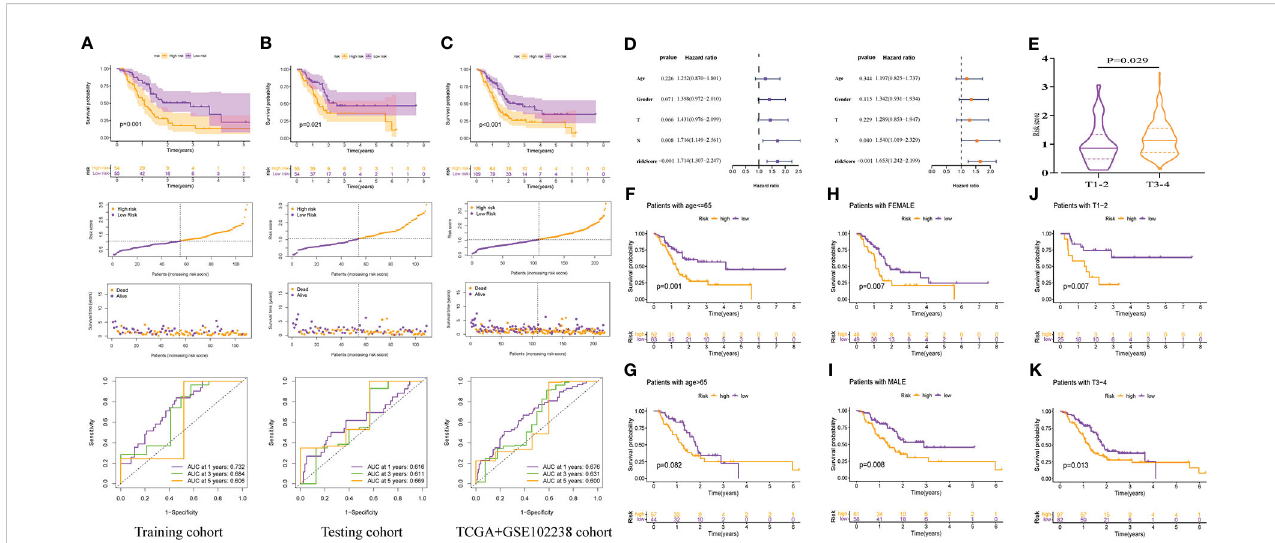
FIGURE 6 Internal cohorts validation of the predicted performance of PMSRP. (A – C) Comparison of overall survival (OS) between the high- and low-risk groups, and time-dependent ROC curves of risk scores in the training (A) , the testing (B) , and the TCGA+GSE102238 cohorts (C) . (D) Univariate and multivariate Cox regression analyses for independent prognostic performance assessment of PMSRPS. (E) Relationship between risk score and T stage. (F – K) The differences in OS between the high- and low-risk groups when patients with age<=65 (F) or >65 years (G) , the gender of female (H) or male (I) , and the tumor T stage of T1-2 (J) or T3-4 (K)